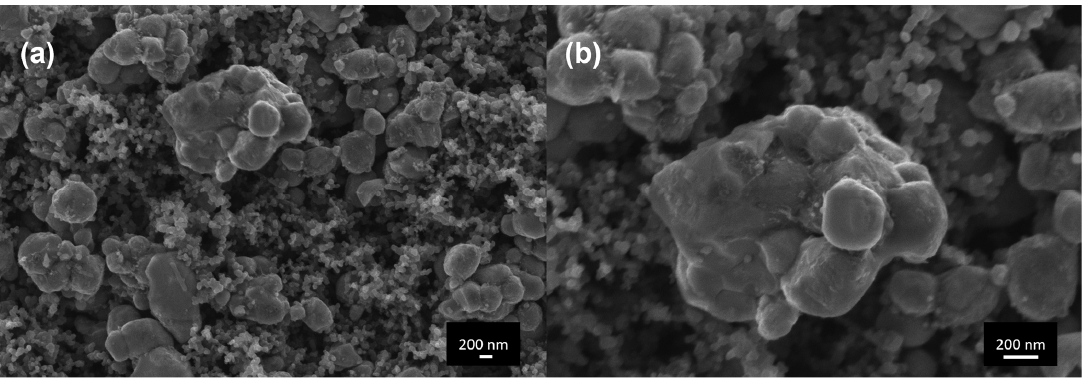
Figure 1. FESEM micrographs of the cathode electrodes ( a ) 50 kX and ( b ) 100 kX.